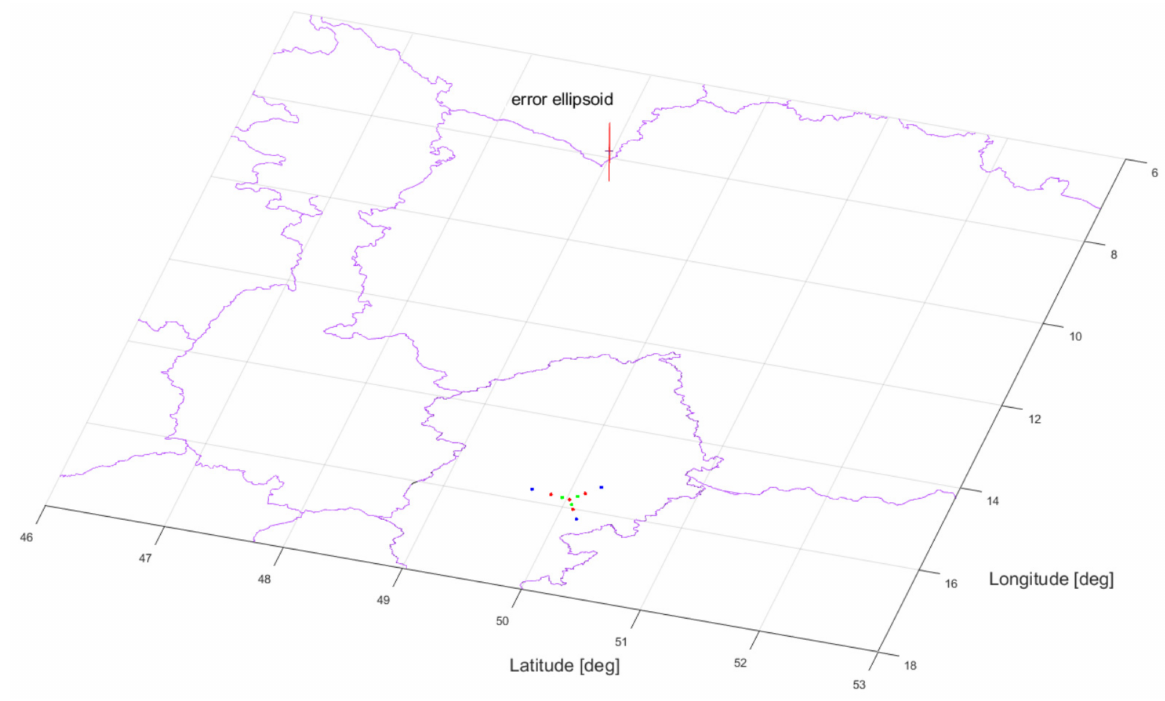
Figure 12. To scale image of the error ellipsoid and the ESM MLAT systems